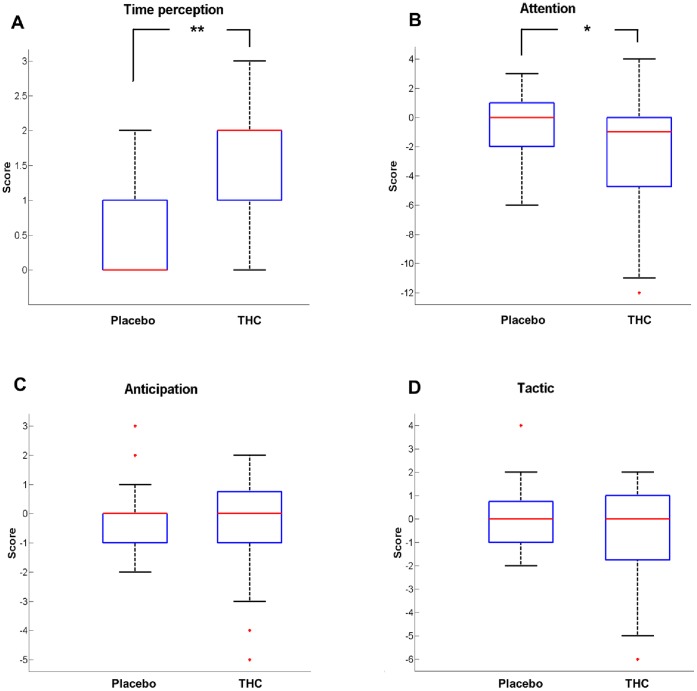
Questionnaire regarding the strategy used to perform the fMRI task.Comparison of the answers given by the volunteers between two experimental sessions (Placebo/THC). The red central mark is the median, the edges of the box are the 25th and 75th percentiles, the whiskers extend to the most extreme datapoints that the algorithm considers not to be outliers (1.5 times the interquartile range), and the outliers are plotted individually with red crosses. Parameters of interest were: alteration in time perception (panel A), attention (panel B), anticipation of the target movement (panel C), and tactic (panel D). Black stars represent the significant difference of the variables of interest between the experimental conditions.